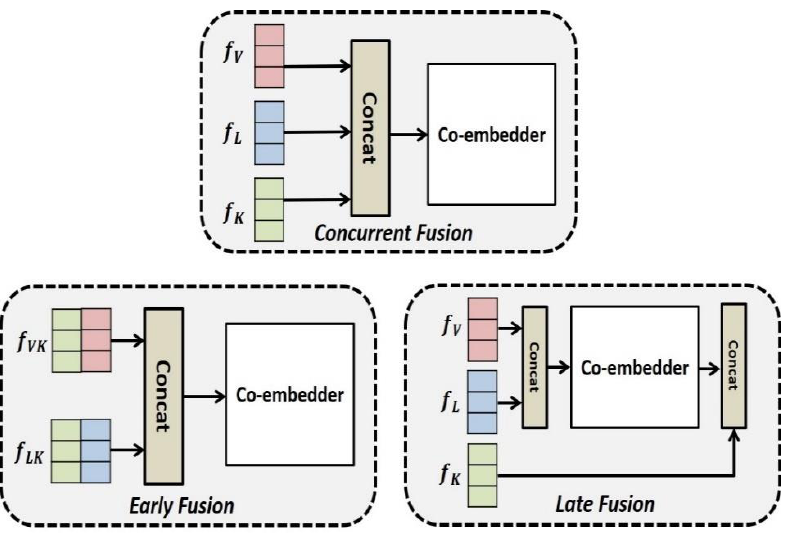
Figure 8. Multimodal embedding methods.